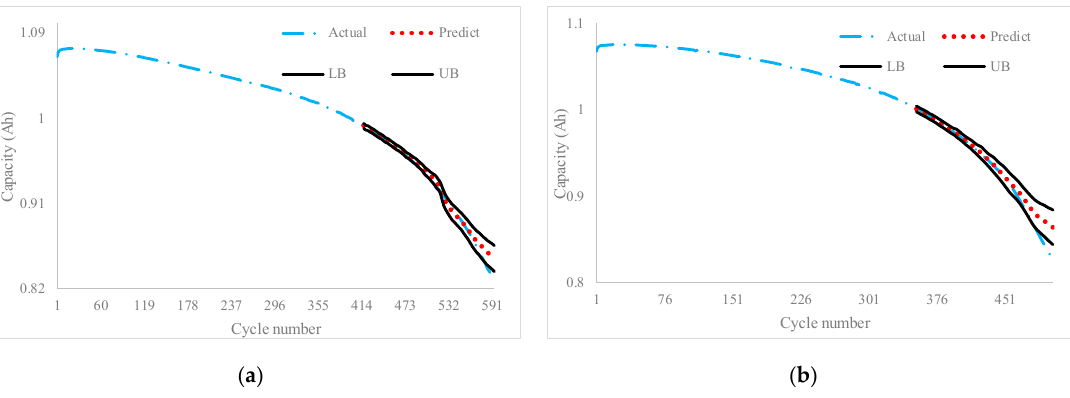
Figure 5. Proposed model prediction intervals: ( a ) cell #2_11 cell and ( b ) cell #2_12.